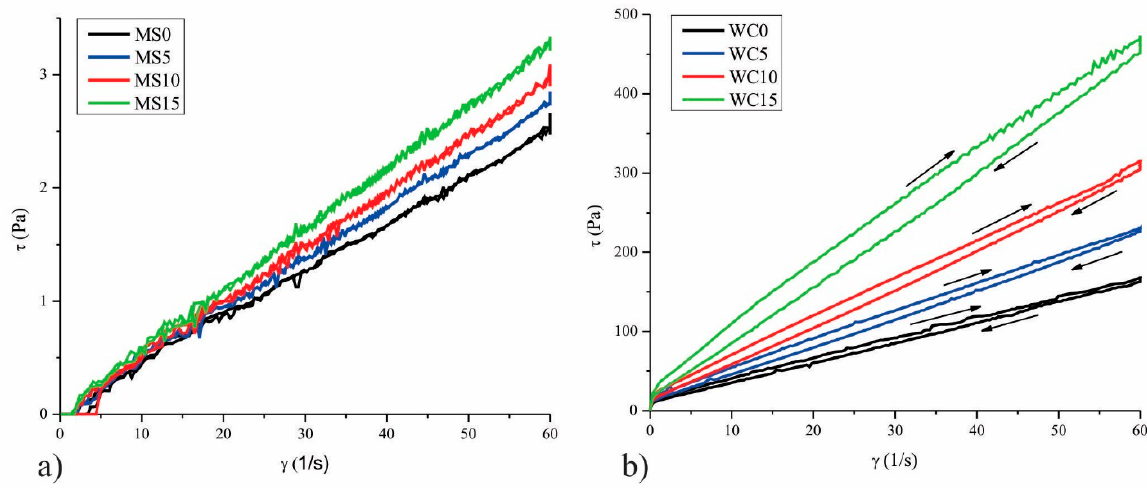
Figure 1. Flow curves of ( a ) model system and ( b ) white chocolate with different amounts of RS. The viscosity of the model system on maximum shear rate (60 1/s) increases with an increase in the amount of RS. White chocolate samples exhibit a thixotropic type of flow.